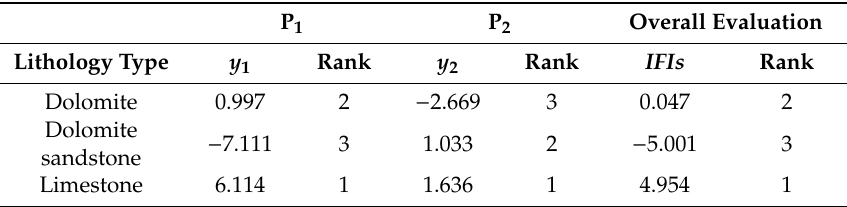
Table 3. Scores and ranks of the principal components of the soil